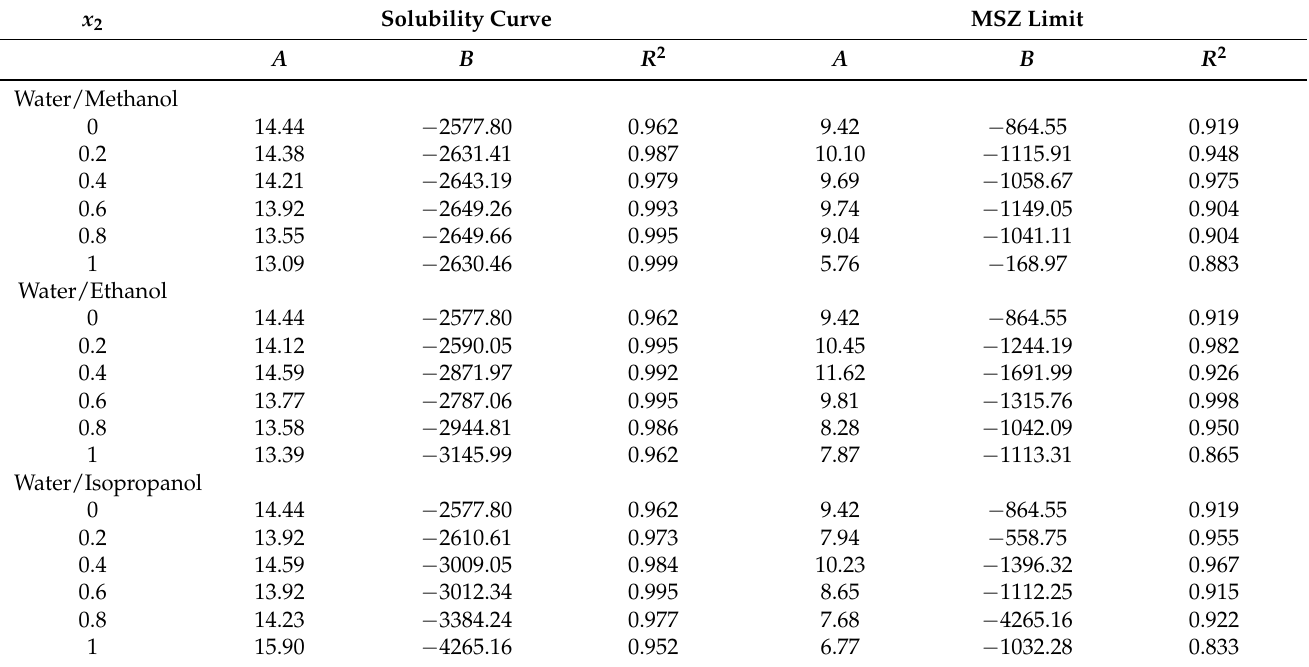
Table 1. Coefficients of Equation (8) representing solubility curve and MSZ